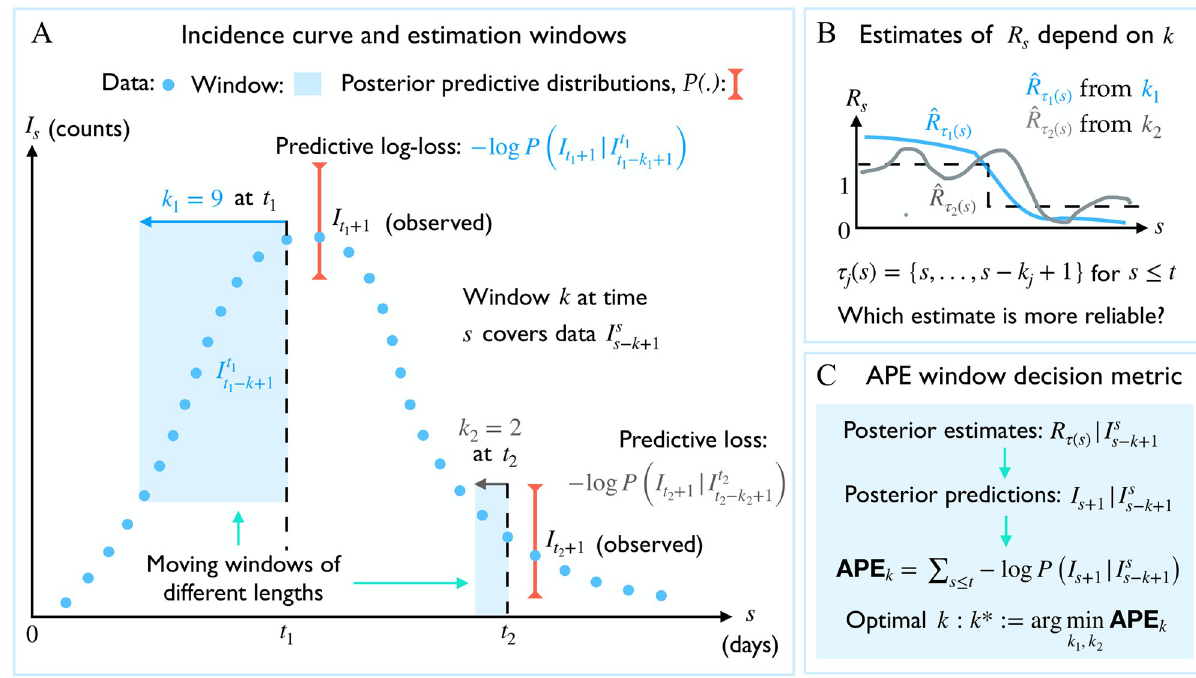
Fig 1. Optimal window selection using APE. (A) An observed incidence curve (blue dots) is sequentially and causally predicted over time s � t using effective reproduction number estimates based on two possible windows lengths of k 1 and k 2 (blue shaded). Predictive distributions are summarised by red error bars (shown only for times t 1 and t 2 , respectively for k 1 and k 2 ), (B) The true reproduction number ( R window length as ^ R (blue) and ^ R (grey). Large windows ( k 1 ) smooth over fluctuations. Small ones ( k 2 ) recover more changes but are noisy. (C) t 1 ð s Þ t 2 ð s Þ The APE assesses k 1 and k 2 via the log-loss of their sequential predictions (i.e. from red error bars across time). The window with the smaller APE is better supported by this incidence curve. See Methods for more mathematical details.